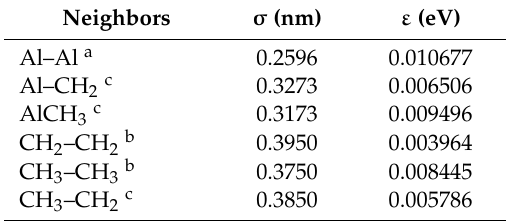
Table 1. Parameters for the Lennard–Jones (LJ) potentials for the non-bonded